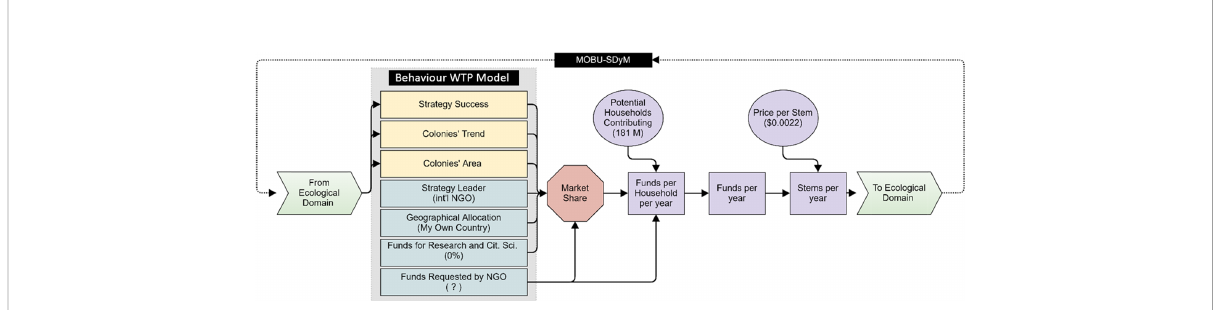
FIGURE 5 Coupled model overview. Black- fi lled squares represent the two domain models used, behaviour WTP and population dynamics (MOBU-SDyM) for the social and ecological domains, respectively. Under the behaviour WTP model ’ s title and within the gray box, rectangles represent the attributes de fi ning the conservation strategy (utility estimate for each of these attributes can be found in Figure 4 ); yellow rectangles represent the shared variables by the two domains and are directly informed by the MOBUS-SDyM ’ s output. The red hexagon represents the proportion of potential donors contributing, termed market share (calculated by Eq. 1 – see text) with the input from the choice model con fi guration. Values in parentheses are the attribute variables used in the simulation. Question mark within the parenthesis of “ Funds Requested by NGO ” denotes that this variable is optimized (sections 2.2 and 2.3). The purple shapes are auxiliary variables that help convert the NGOs ’ funds into stems per year that feedback into the ecological domain. We obtained the number of potential households from www.census.gov and set the price per stem based on